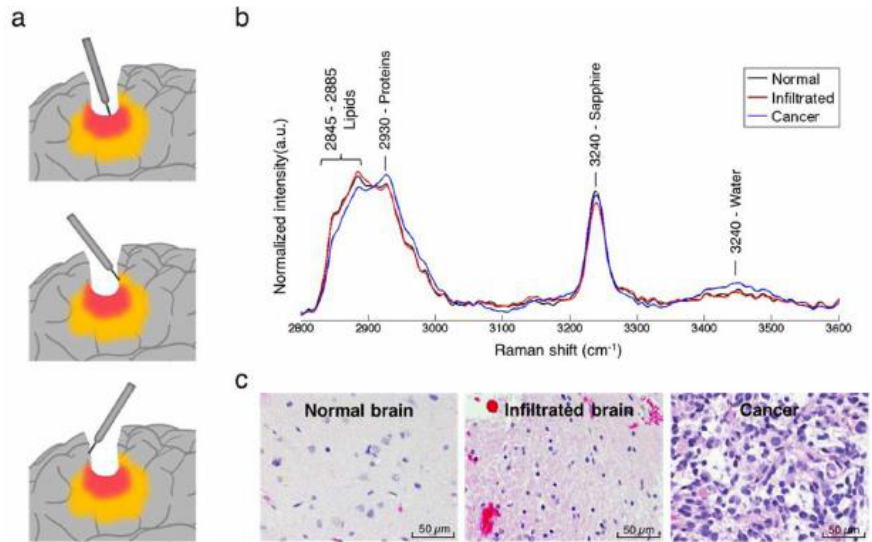
Figure 6. ( a ) The scheme of the Raman measurements from various brain regions with the dense tumor, peritumor with infiltrating tumor cells and without cancer cells recorded during brain surgery. ( b ) Raman spectra of cancer cells, peritumoral region with infiltrated tumor cells and of normal brain region. ( c ) Microphotographs for each brain tissue type. Reprinted from [197] with permission